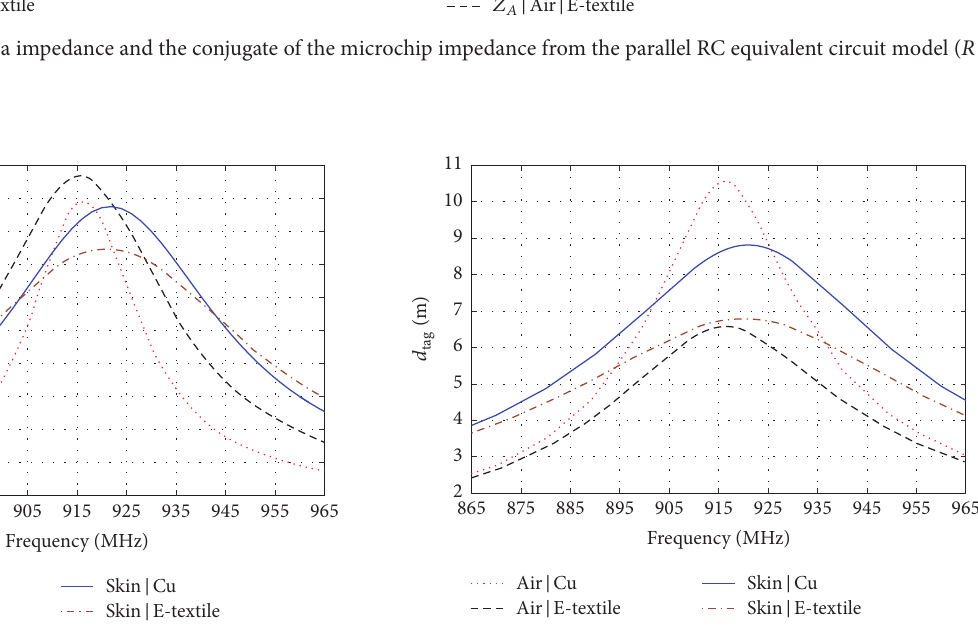
= − emission limit of EIRP = 3.28 W and 𝑃 ic 0